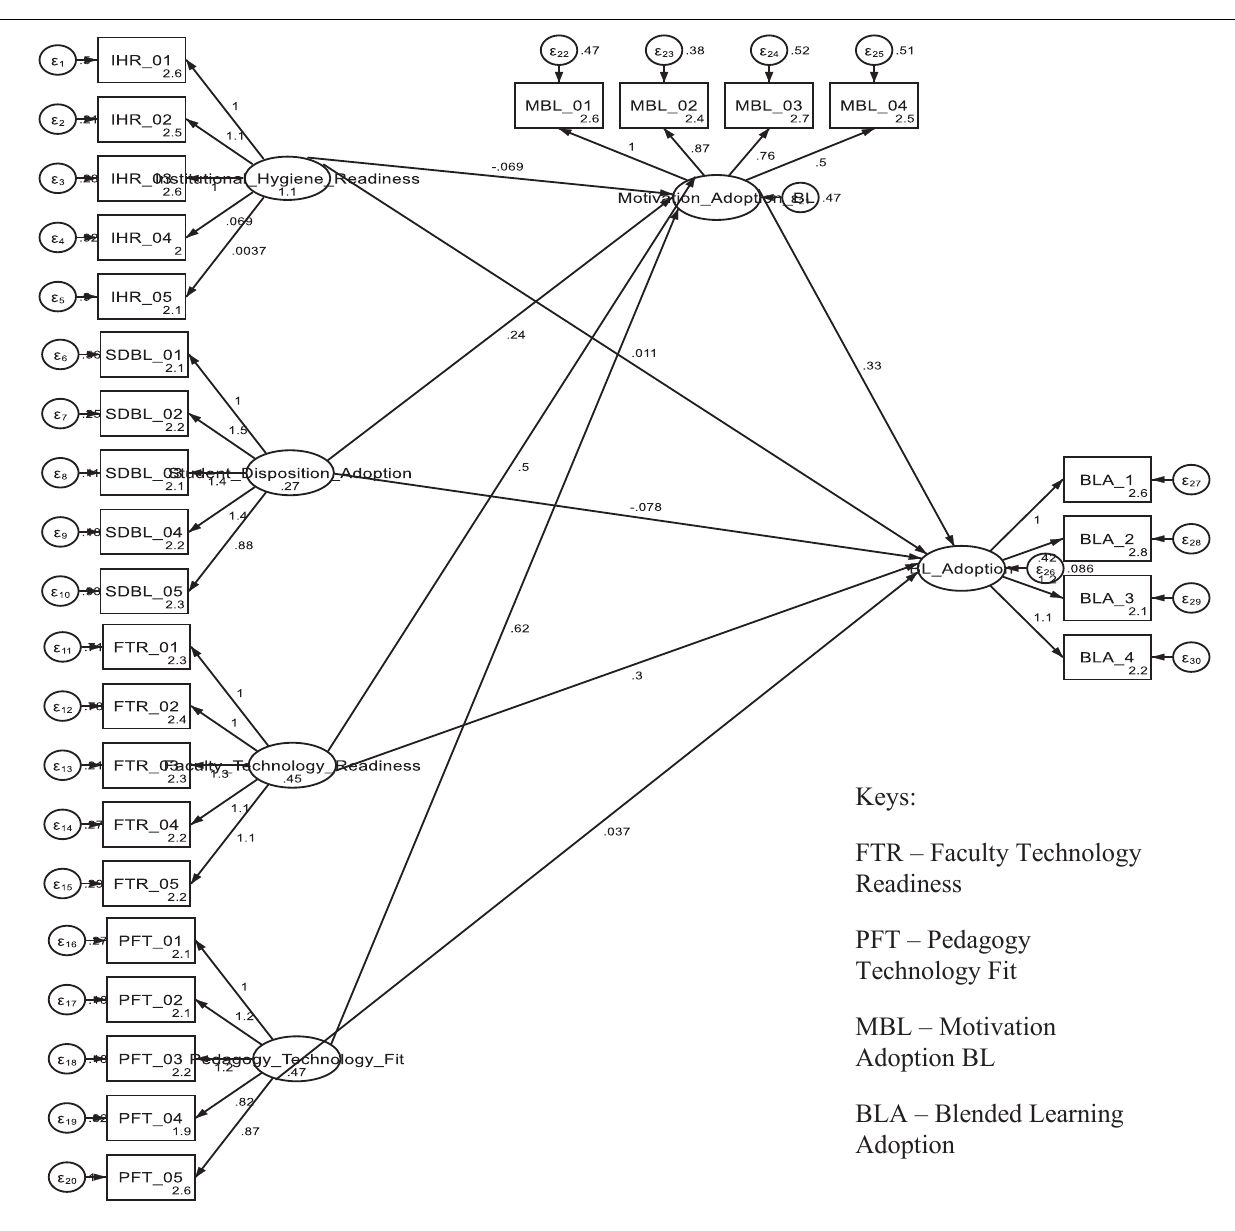
FIGURE 2 | Hypothesized model structural equation model. Source: Field Data